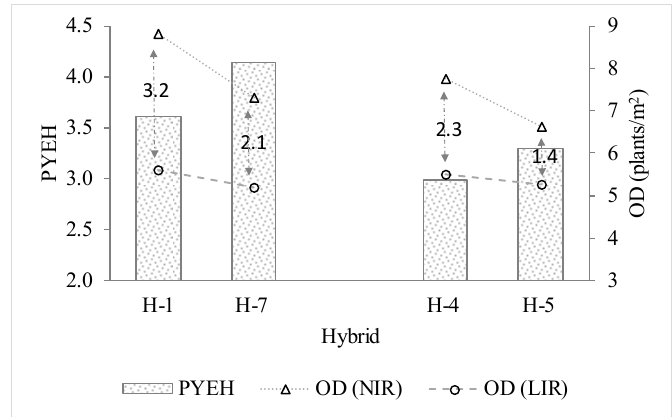
Figure 4. The influence of genotype plant yield efficiency by homeostasis (PYEH) on optimum density (OD) at normal (NIR) and low irrigation regime (LIR). Two hybrids are compared, supposed equivalent in attainable crop yield (ACY) (Table 1), i.e., H-1 vs. H-7 and H-4 vs. H-5. Improvement of PYEH may lower the OD in favorable seasons and bridge the across seasons gap in OD (value on the two-way arrow is the between NIR and LIR difference).